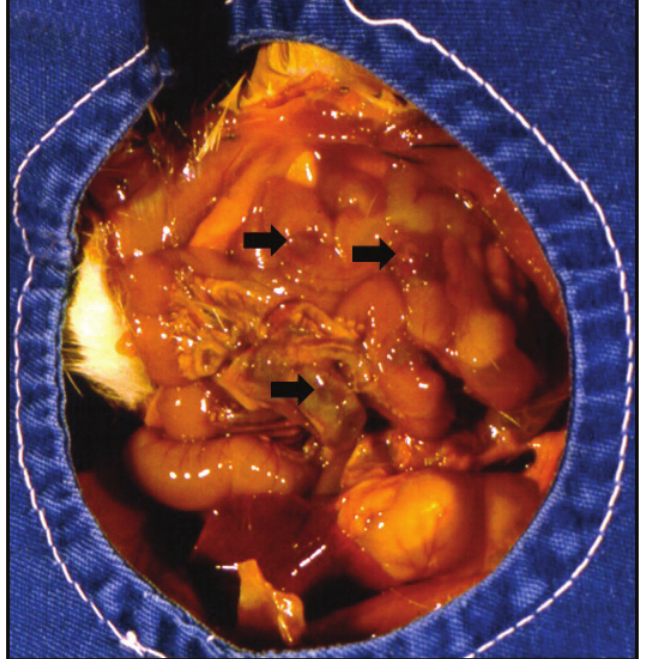
FIGURE 5 - Peritonitis and perforation of Peyer’s patches (arrows) found during necropsy of a recipient sacrificed with signs of